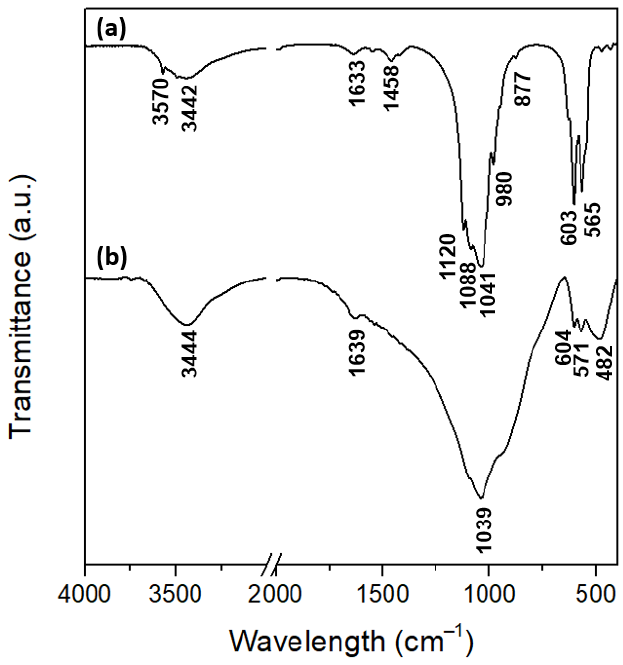
Figure 5. FTIR spectra of CB-CaP ( a ) and AP40mod ( b ) powders.